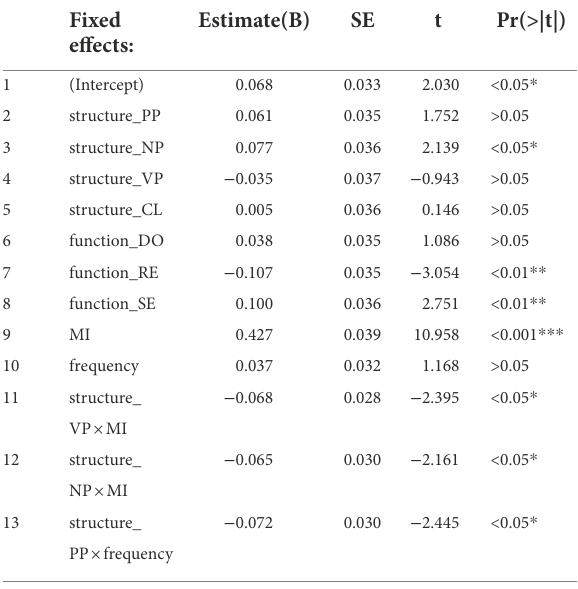
TABLE 3 Fixed effects in the best model (model